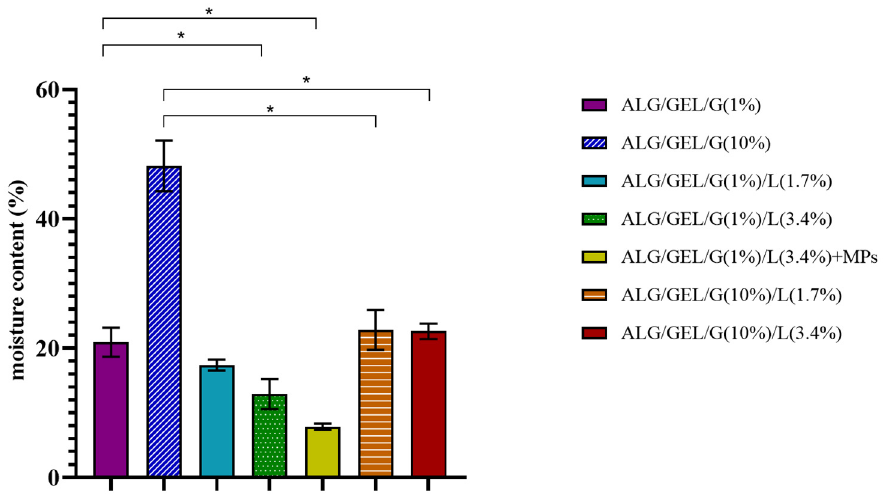
Figure 7. The moisture content of prepared polymeric films with different amounts of glycerol compared to the control samples (without lipids) (* indicates a difference at p < 0.05).